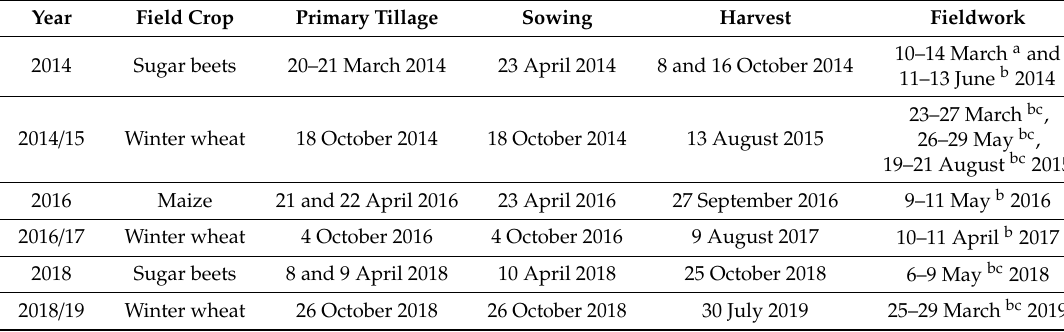
Table 1. Crop rotation, important field activities and dates of field